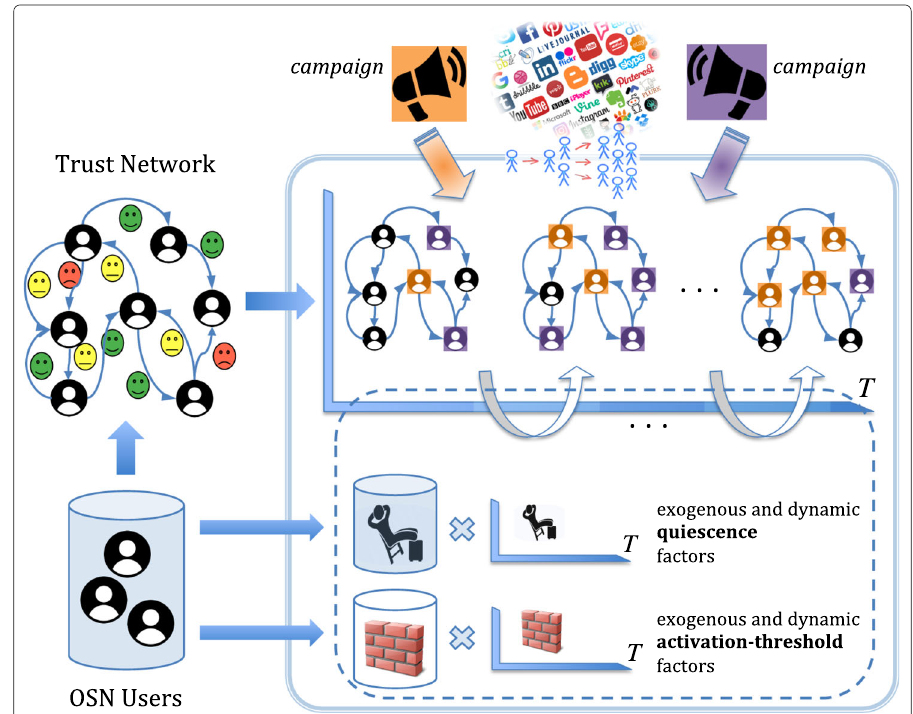
Fig. 1 Illustration of the information diffusion framework based on our proposed F 2